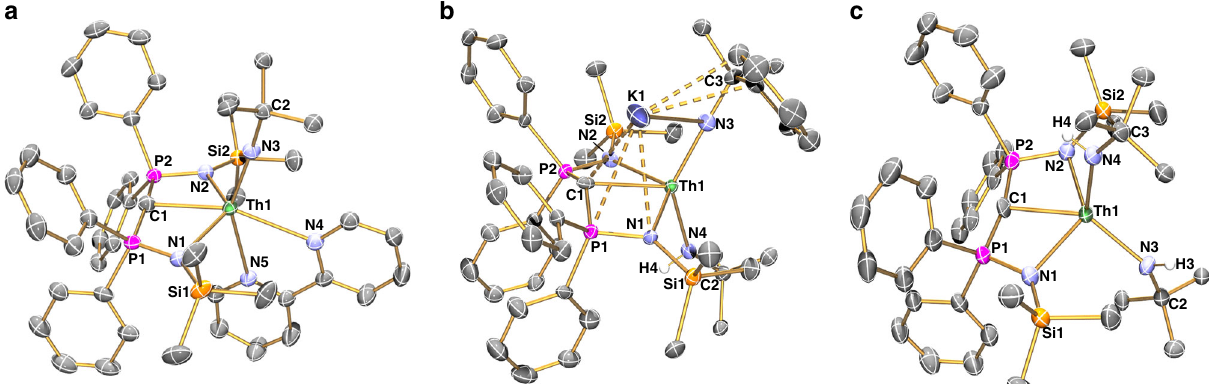
Fig. 3 Molecular structures of the molecules reported in this study. a 2ThBIPY , b 2ThNHRK , and c 4 . Structures were determined at 120 K and are shown with displacement ellipsoids set to 40%. Hydrogen atoms, minor disorder components, lattice solvent, and non- ipso trityl-phenyl ring carbon atoms, unless involved in a novel binding interaction, are omitted for energy scans; the available data are presented in Supplementary Table 2. In [C] = Th = NCH 3 , the maximum of the energy surface scan is at 164.7°, and this point is 27.1 kJ mol − 1 above the opti-